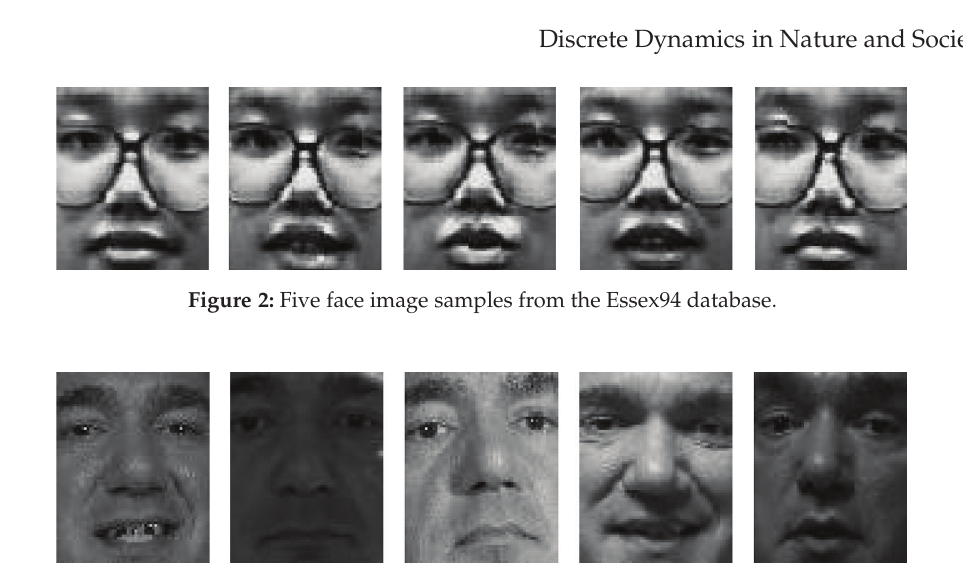
Figure 3: Five face image samples from the FRGC